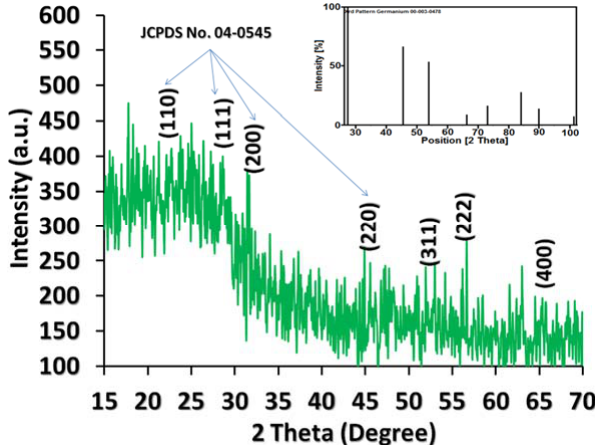
Fig. 4. X-ray diffraction pattern of the dried germanium nanocrystals.